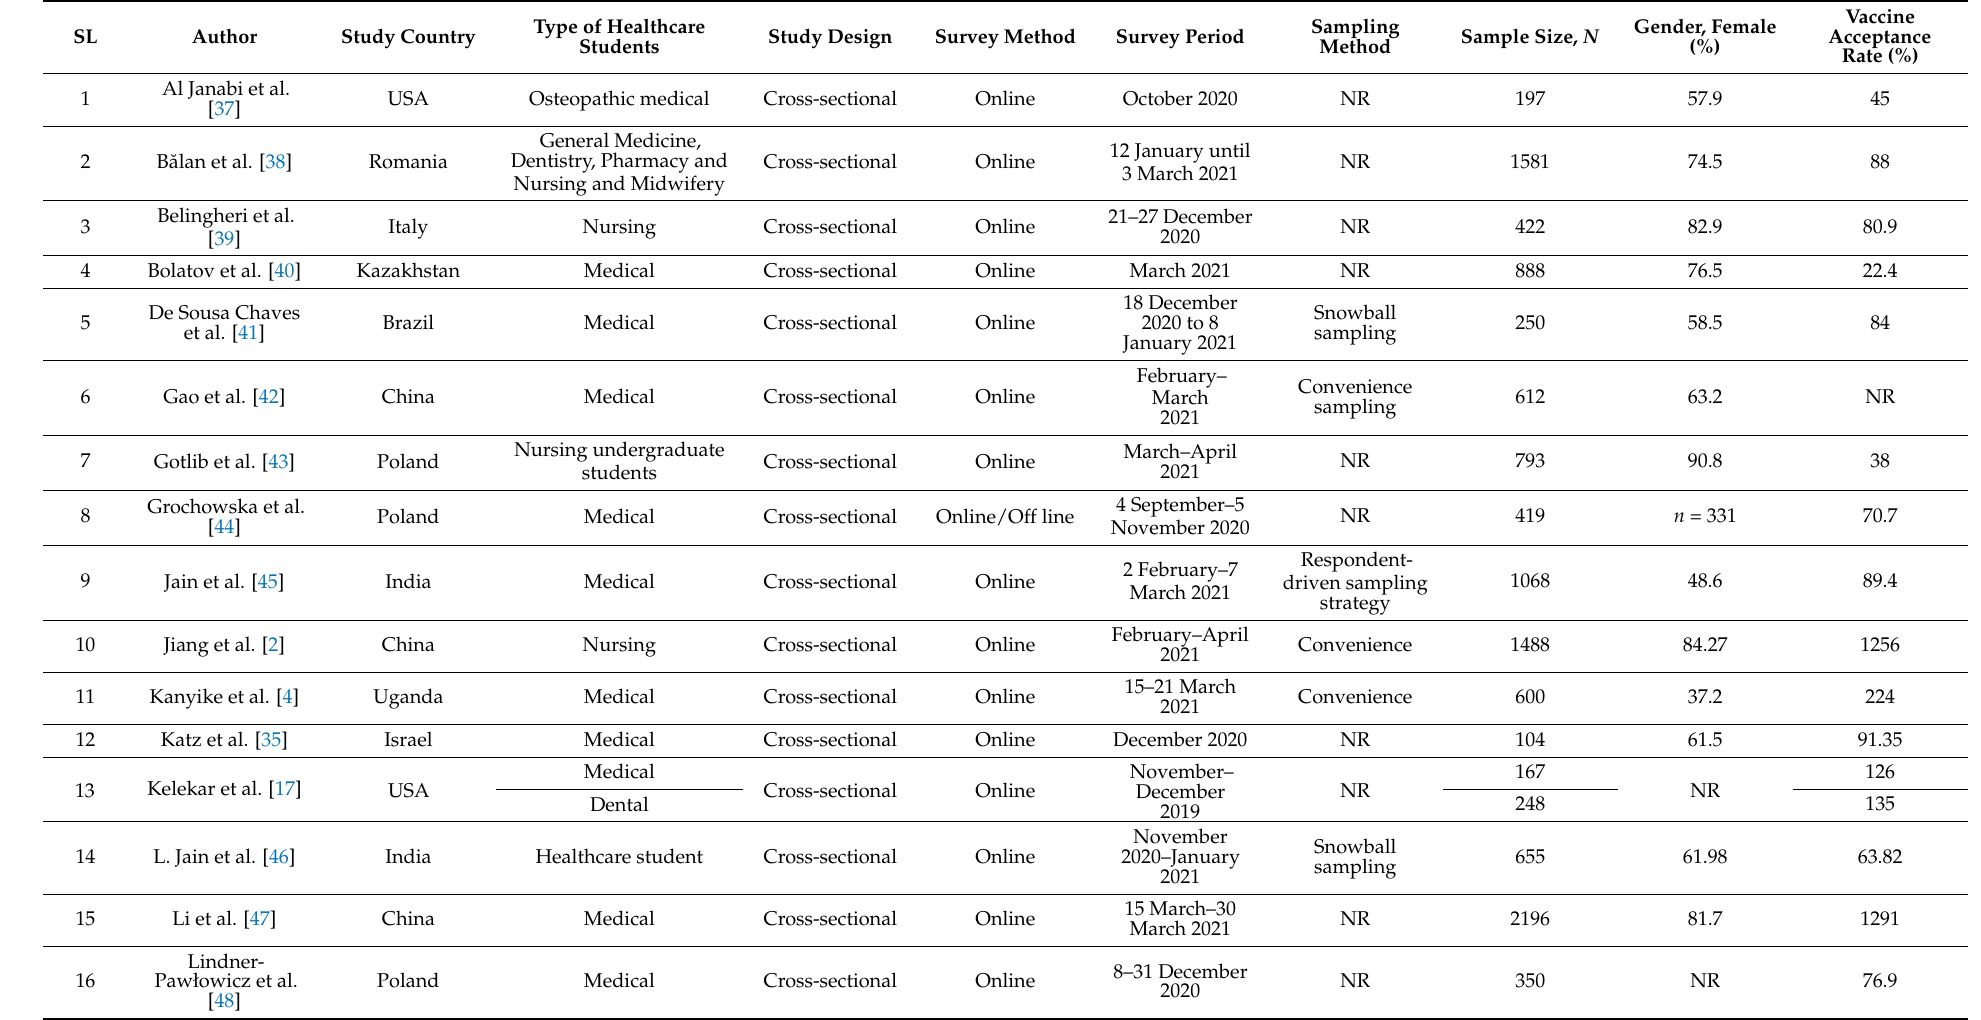
Table 1. Characteristics of included